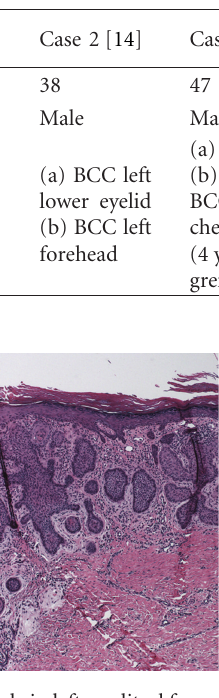
Figure 5: Histopathology of papule in left popliteal fossa consistent with nodular basal cell carcinoma.